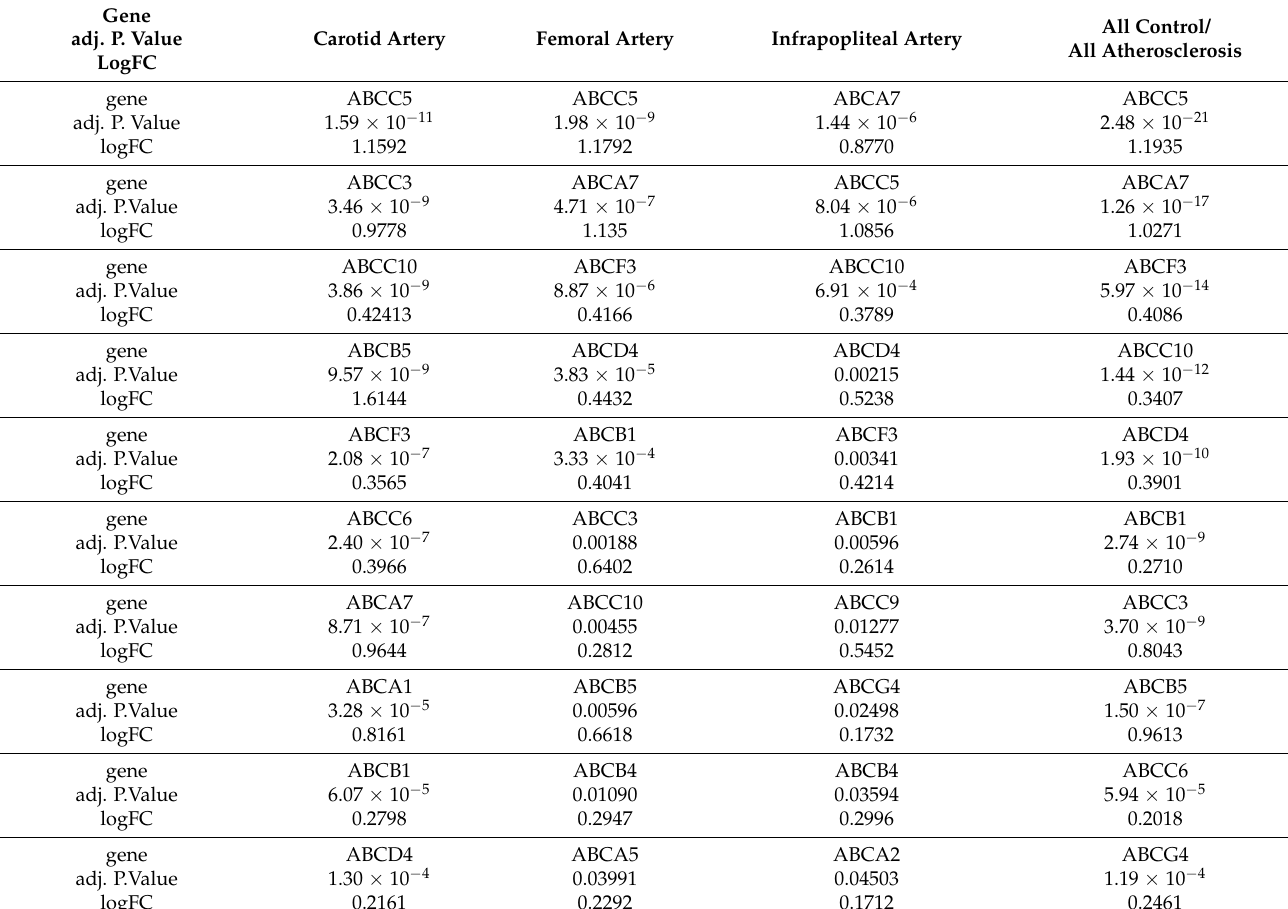
Table 1. The first 10 upregulated ABC genes, ranked by p values adjusted using the algorithm of Benjamini–Hochberg (adj. P. Val). Gene adj. P.